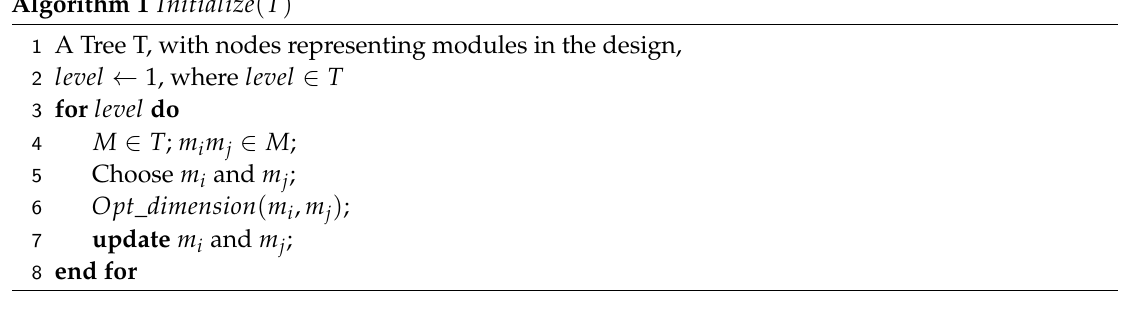
Algorithm 1 Initialize ( T )